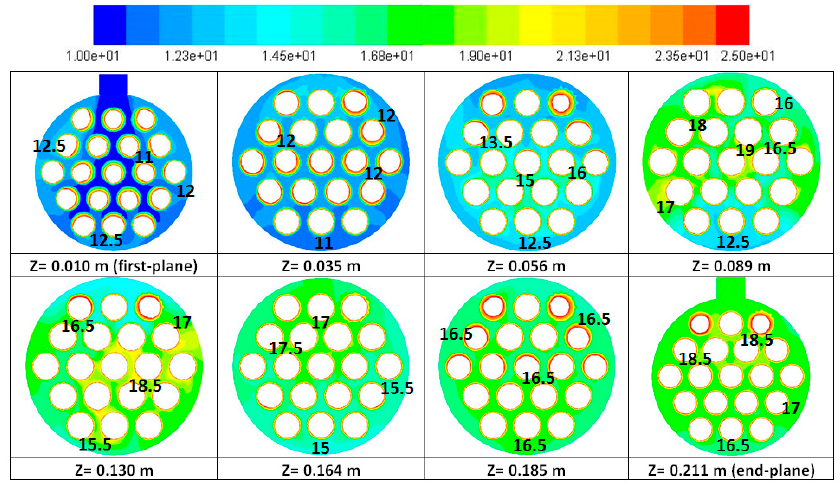
Figure 11. Prediction of temperature (°C) distribution at section planes defined in shell side (Case-II). Energies 2017 , 10 , 1156